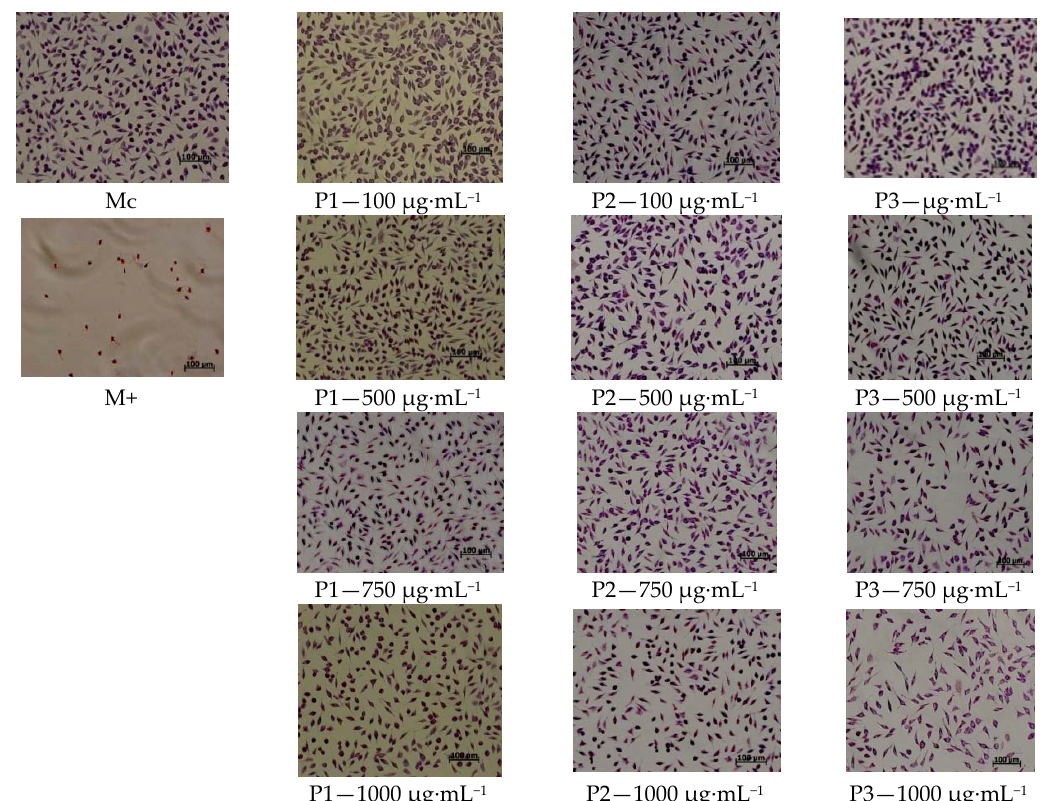
Figure 9. Cellular morphology after interaction with different concentrations for the P1, P2 and P3 samples (magnification 20×).